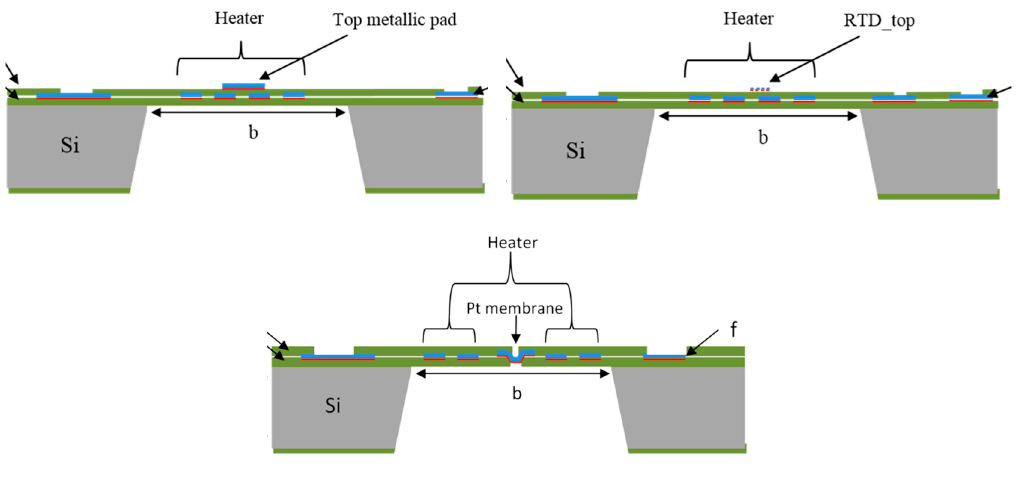
Figure 1. The three calibration chips designs.